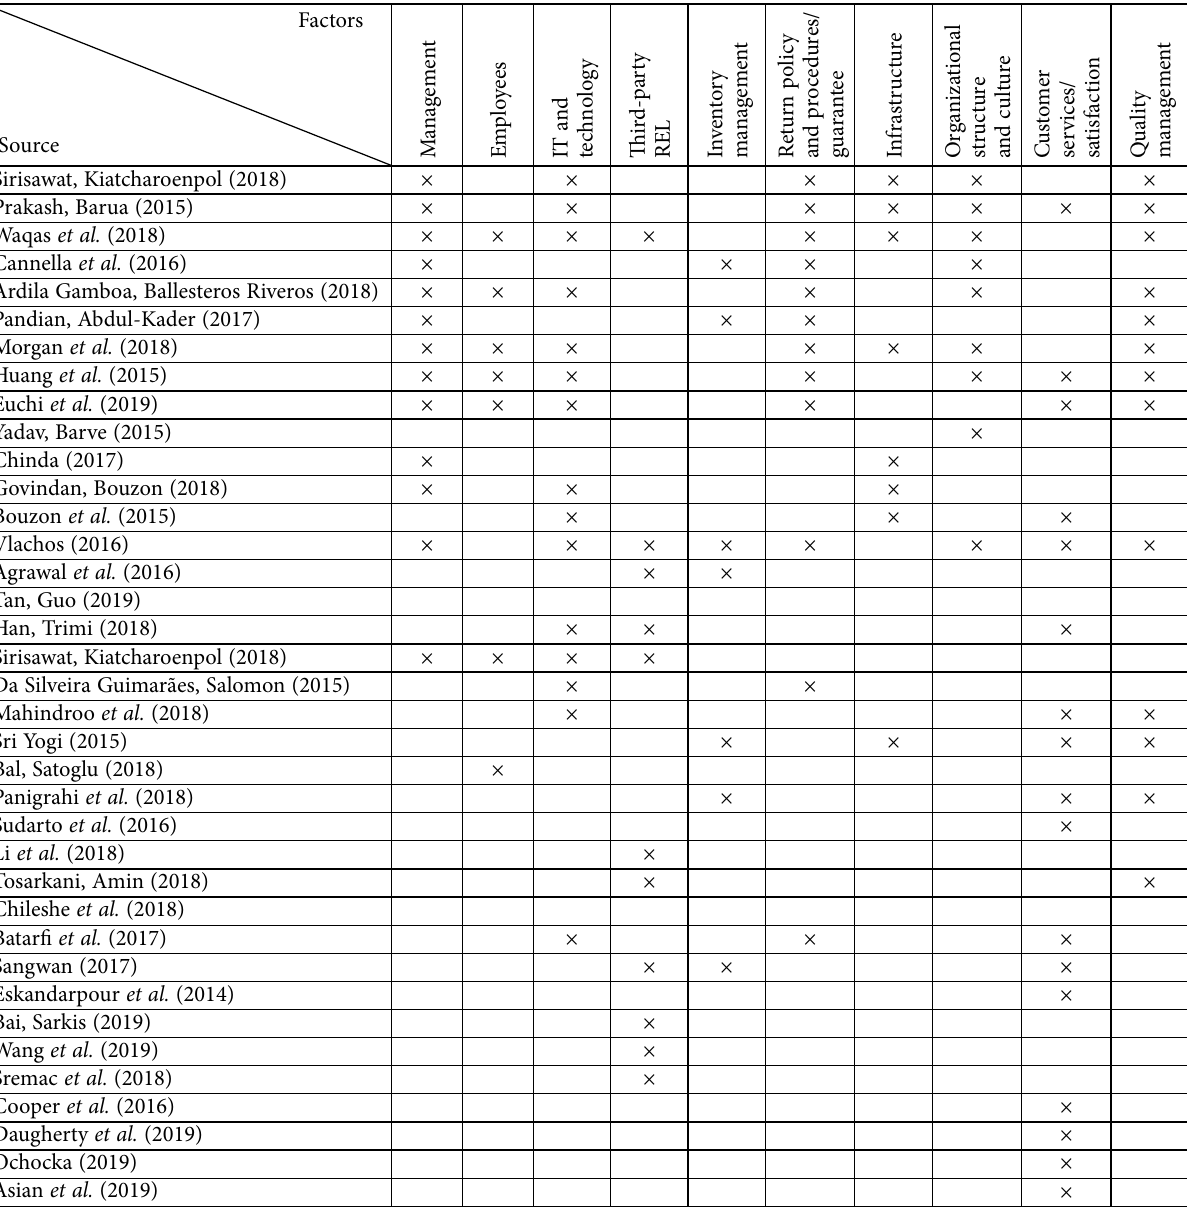
Table 4. Factors affecting REL’ performance (source: compiled by authors 2020)